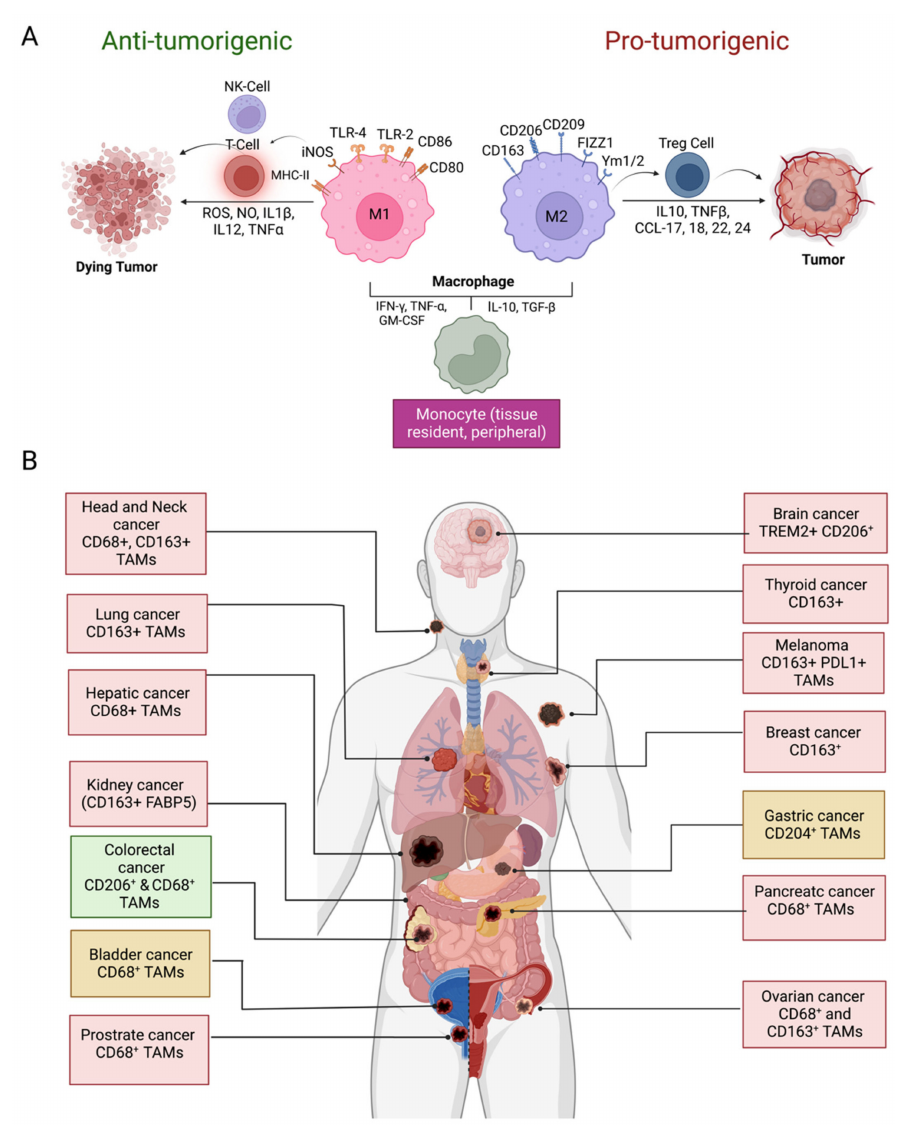
Figure 1. Macrophage polarization and prognostic significance in cancer. ( A ) Differentiation of monocytes in M1 and M2 macrophages in the TME and their role in tumor suppression and pro- motion, respectively; ( B ) prognostic significance of TAM density in various cancer types and IHC markers used for TAM identification. Presence of TAMs correlates with the unfavorable disease prognosis in glioblastoma, thyroid, lung, hepatic, kidney, ovarian, head and neck, breast, prostate, and melanoma (red boxes) whereas favorable prognosis (green box) in colorectal cancer. Both favorable and unfavorable correlations have been reported in gastric cancer and bladder cancer (yellow boxes). Abbreviations: NK, natural killer; ROS, reactive oxygen species; NO, nitric oxide; IL, interleukin; TNF, tumor necrosis factor; MHC, major histocompatibility complex; iNOS; inducible nitric oxide synthase; TLR, toll-like receptor, IFN, interferon; TGF, tumor growth factor; GM-CSF, colony-stimulating factor; Treg, regulatory T lymphocytes; FIZZ1, resistin-like molecule α , Ym1/2; chitinase-like protein Ym1/2, CCL; C-C chemokine ligand; CD, cluster of differentiation; FABP5, fatty acid binding protein 5; TREM, triggering receptor expressed on myeloid cells; PDL1, programmed death ligand 1 (Figure created with BioRender.com accessed on 15 December